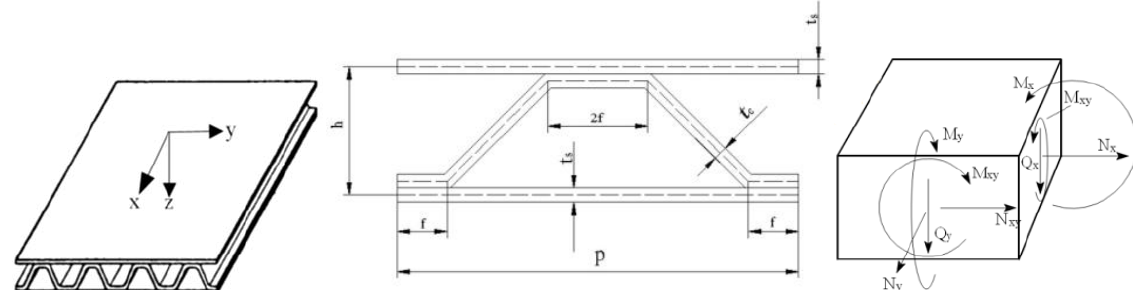
Figure 1: Axonometric view of the sandwich (left), definition of geometric parameters of the transversal section (middle), homogenised unit cell (right).